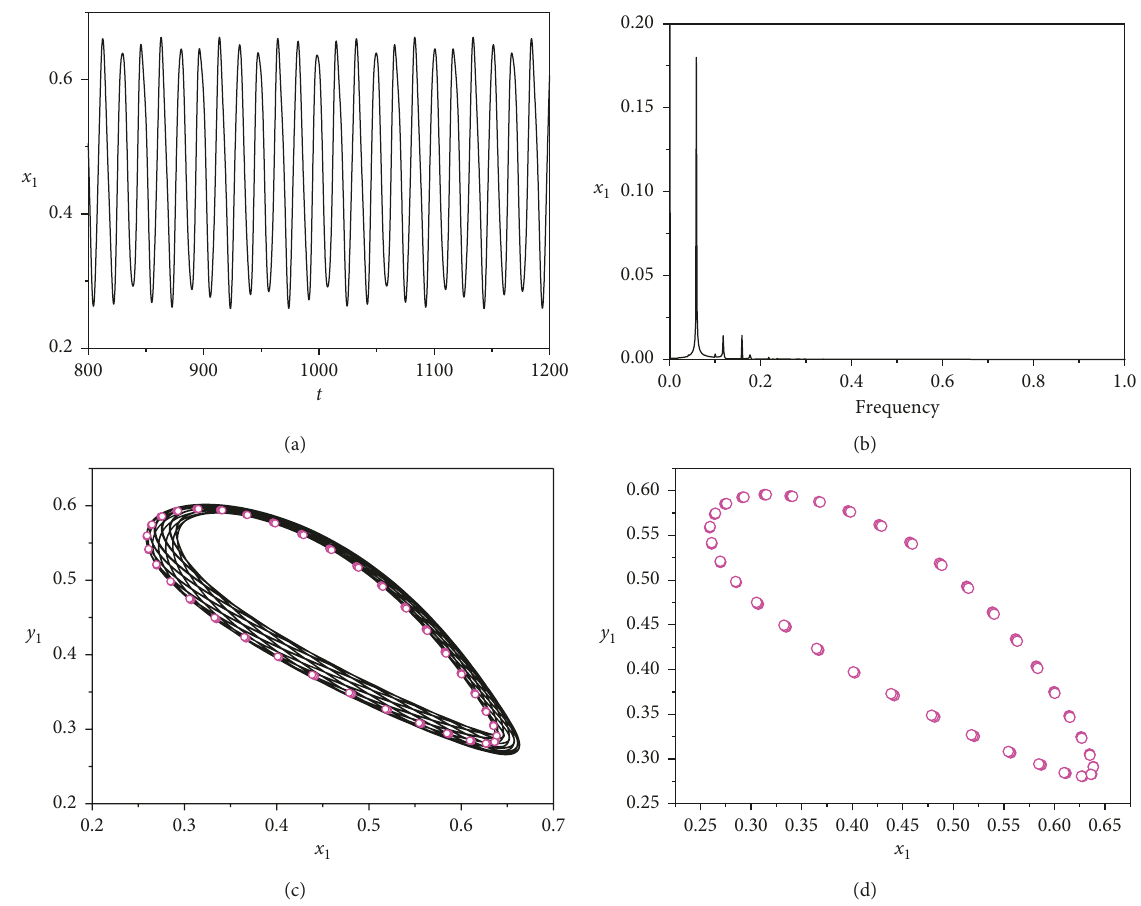
Figure 8: ω � 3.50: (a) displacement response; (b) frequency spectrum; (c) rotor orbit; (d) Poincar´e